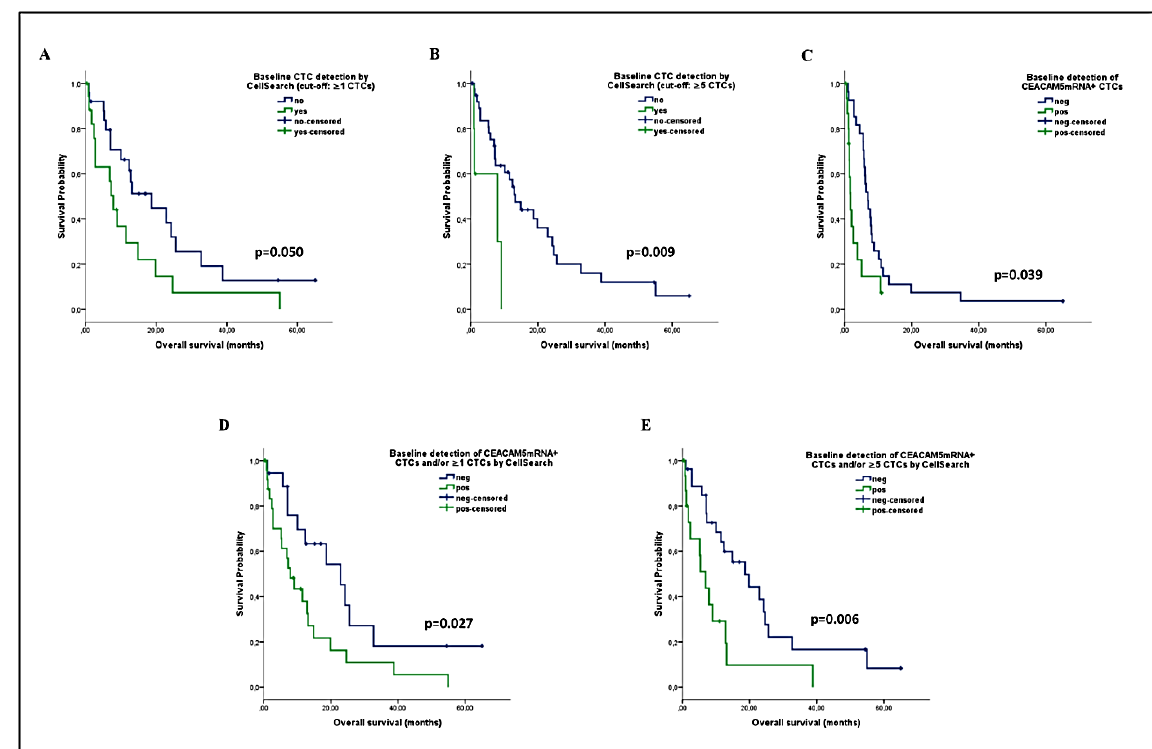
Figure 3. Progression-free survival (PFS) analysis among patients with NSCLC undergoing first-line chemotherapy, ac- cording to the baseline detection of CTCs by using the CellSearch or the CEACAM5 mRNA assay ( A – C ) or by their combi- nation ( D , E ).